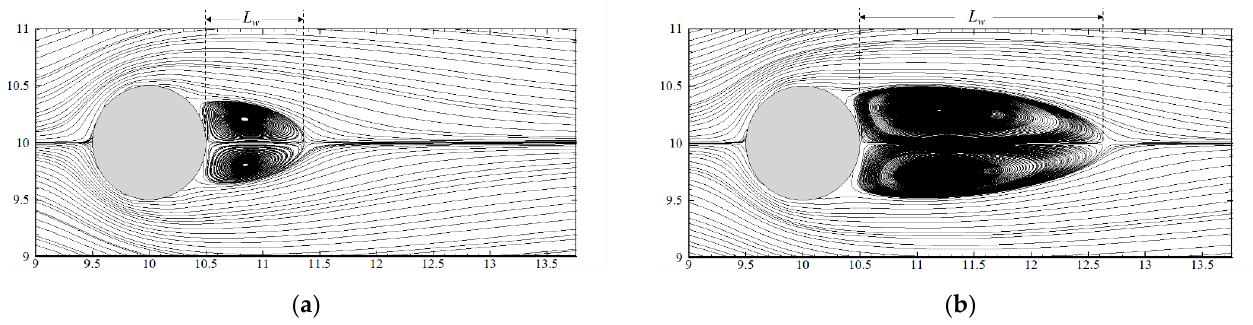
Figure 3. Streamlines near the cylinder for Re = 20 ( a ) and Re = 40 ( b ). Table 1. Comparison of the drag coefficient and the length of steady state wake for Re = 20 and Re = 40. Re = 20